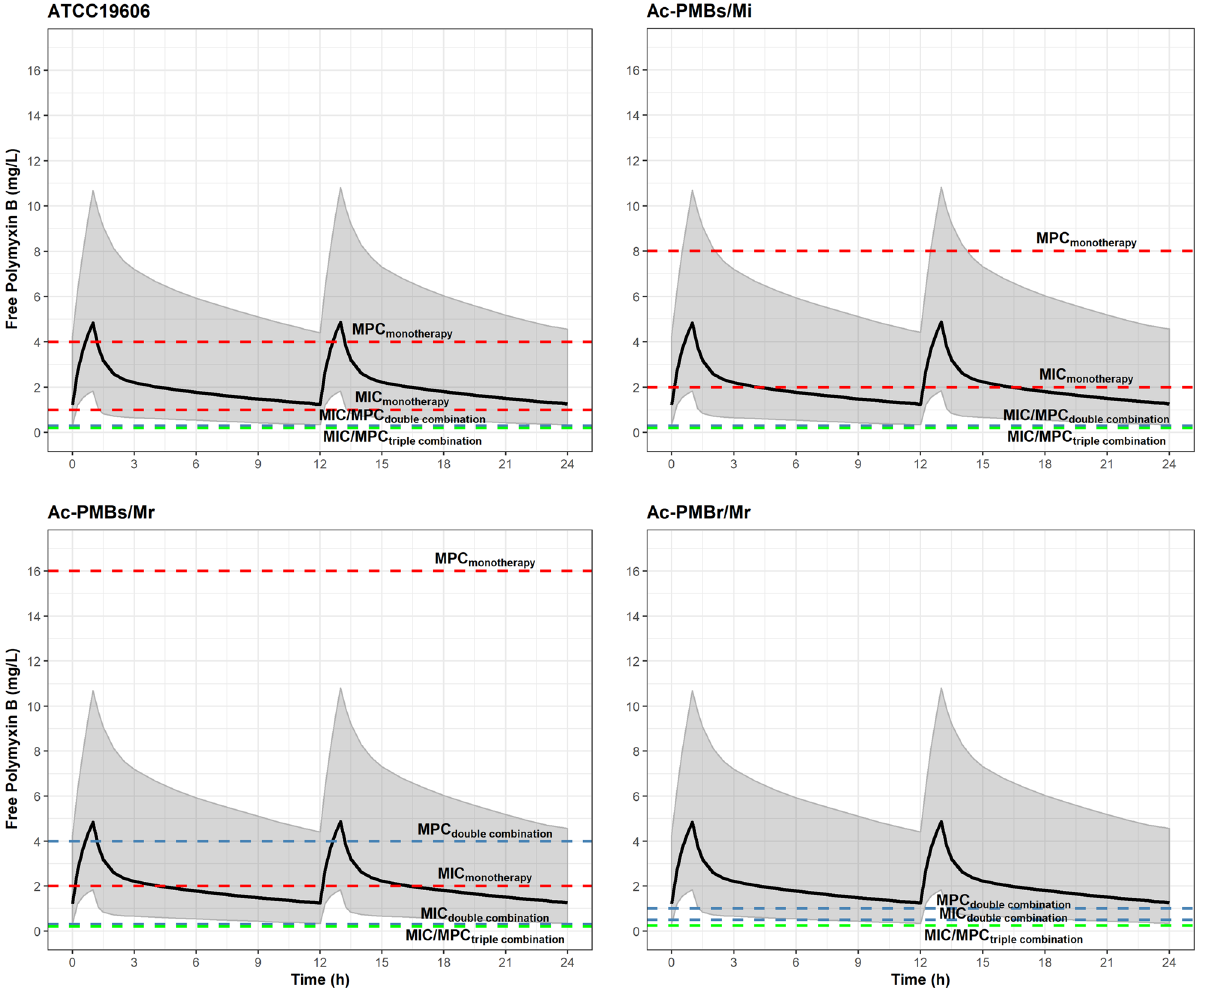
Figure 3. Simulated median and 95% prediction interval of free drug concentrations, as represented by solid black lines and grey shaded areas, respectively, in virtual patients against A. baumannii strains. The dosing regimen of polymyxin B at 1.5 mg/kg q12h with 1-h infusion was simulated in 10,000 virtual patients. MIC and MPC values in monotherapy (red), two- (blue), and three-drug combination (green) are shown by dashed